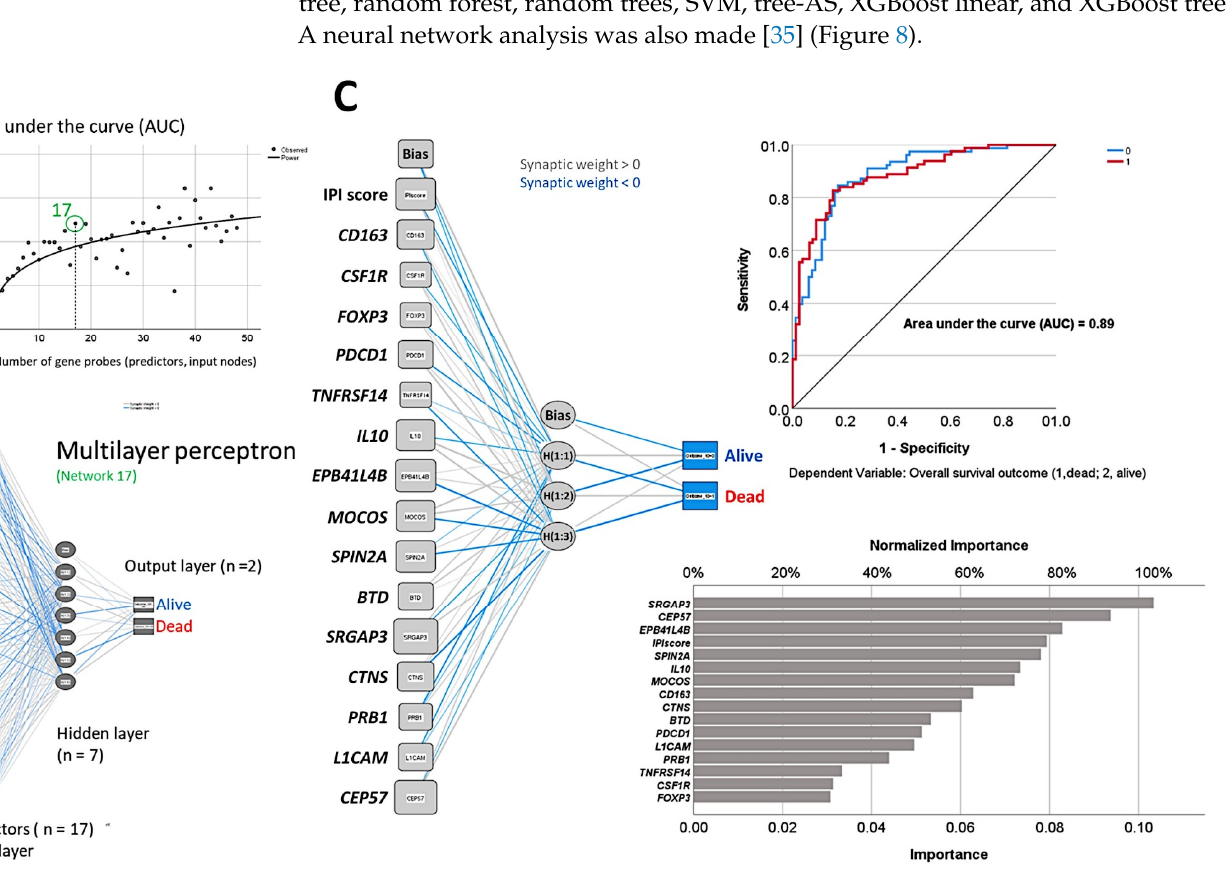
Figure 8. Prediction of the overall survival of follicular lymphoma taking advantage of the random number generator. ( A ) By using the random generator, 120 independent and different neural network solutions were calculated, and the averaged normalized importance of each gene for predicting the overall survival was recorded. Then, the minimal number of genes of a neural network with sufficient performance was selected, and a final neural network with 17 genes was defined. ( B ) This neural network (multilayer perceptron type) included 17 genes in the input layer, a hidden layer of 7 nodes, and an output layer of 2 nodes (overall survival, death vs alive). ( C ) A new neural network was created with the highlighted 17 genes and known immuno-oncology genes. The resulting model had an acceptable accuracy, with an area under the curve (AUC) of 0.89. The predictors (inputs) were ranked according to their normalized importance in predicting the overall